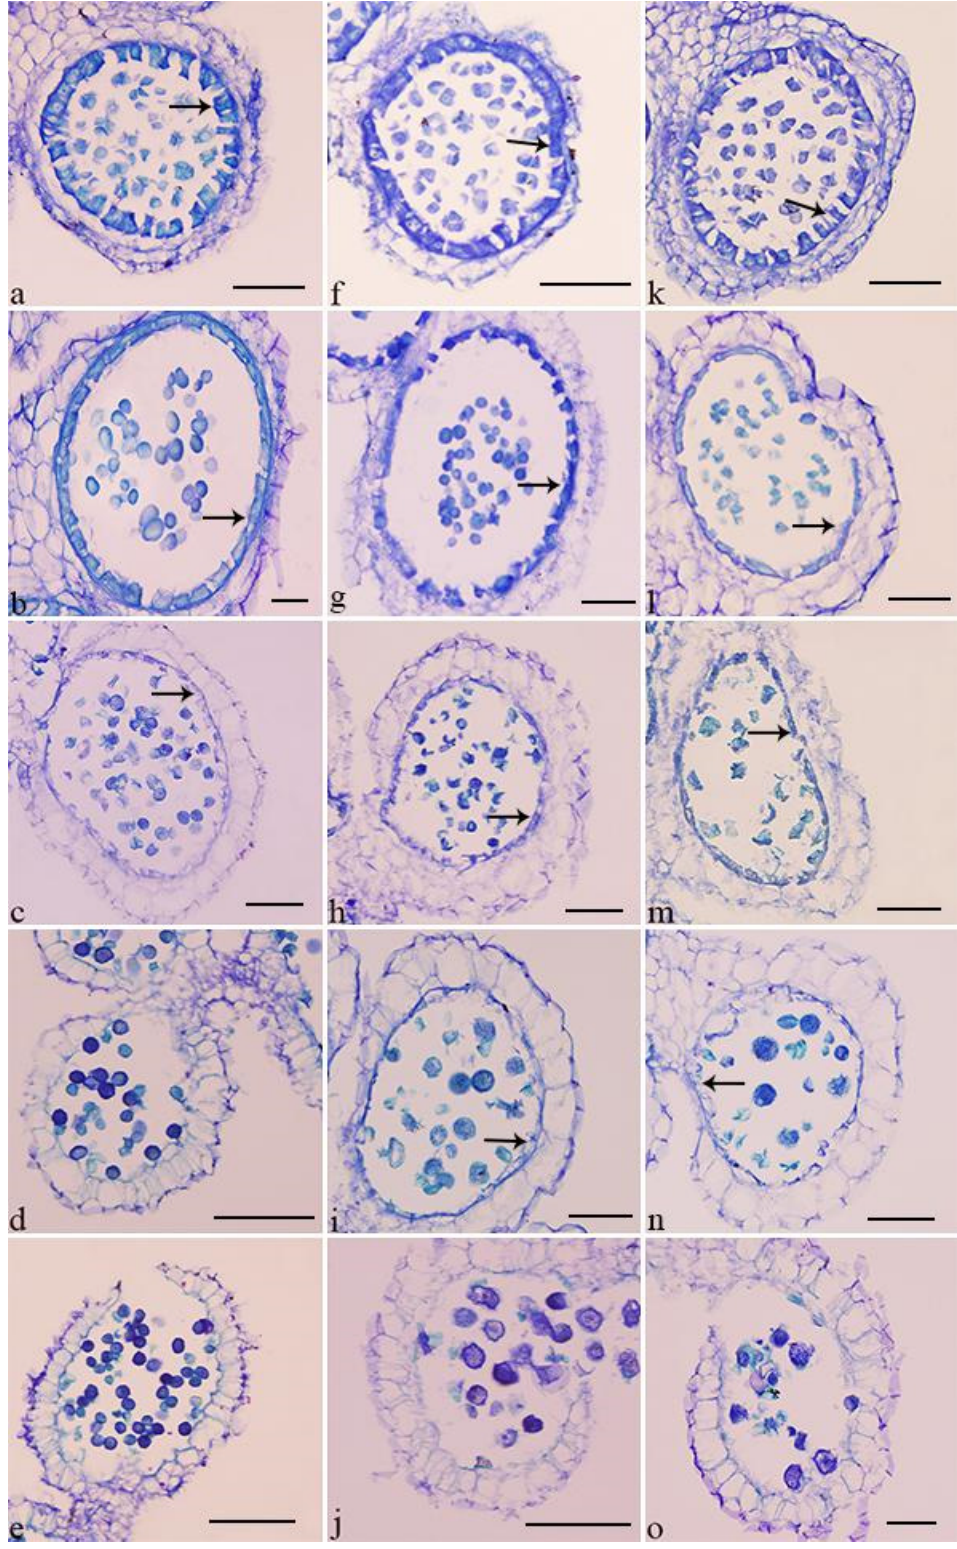
Figure 5. Tapetum development of anthers of P. canescens male flower buds exposed to high temperature (38 °C for 3 h or 6 h) or 25 °C (control). ( a – e ) Tapetum development of anthers from the control group. ( f – j ) Tapetum development of anthers exposed to 38 °C for 3 h. ( k – o ) Tapetum development of anthers exposed to 38 °C for 6 h. Scale bars = 5 μ m.